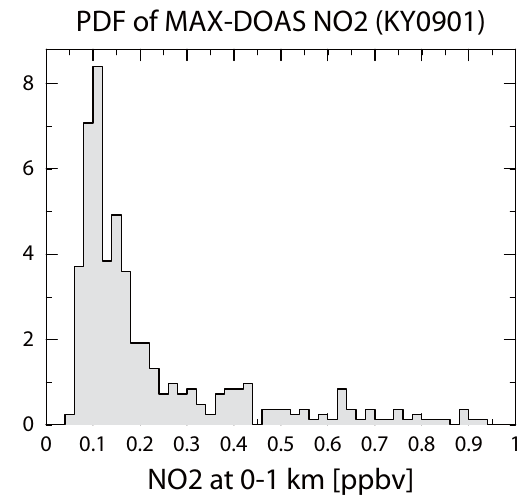
Fig. 10. NO 2 variations over the ocean for 0–1km during the KY09- 01 cruise. Pink lines show the 48-h backward trajectory for NO 2 concentrations higher than 0.3ppbv. The trajectory was calculated using meteorological analysis data from the Japan Meteorological Agency’s Climate Data Assimilation System (JCDAS) reanalysis with a kinematic trajectory model.